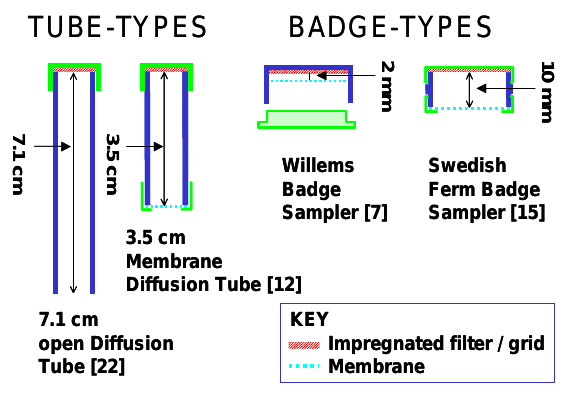
FIGURE 1. Some examples of tube-type and badge-type passive diffusion samplers.